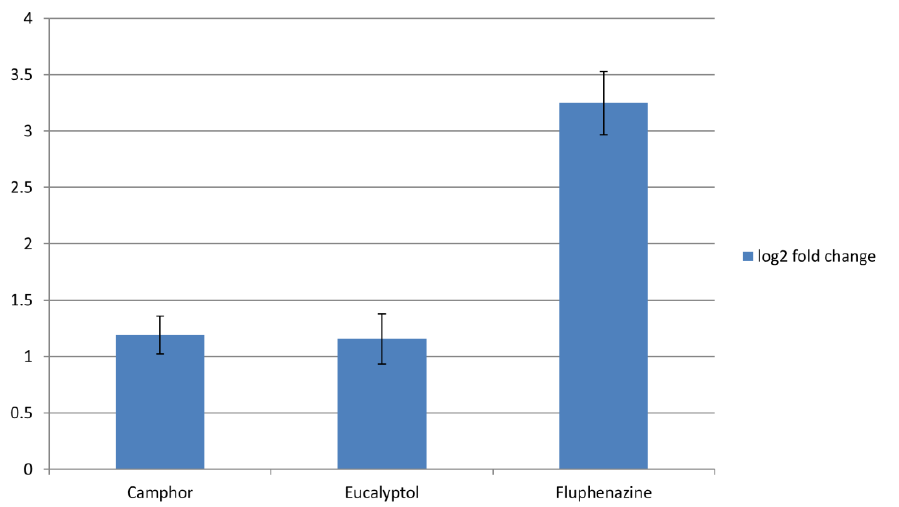
Figure 5. Expression levels of CDR1 after treatment with MIC of camphor and eucalyptol; fluphenazine was used as a positive control for CDR1 expression. Values are expressed as the log2 fold change (log2 FC) of Relative Quantification (RQ) values and presented as an average of two biological replicates.